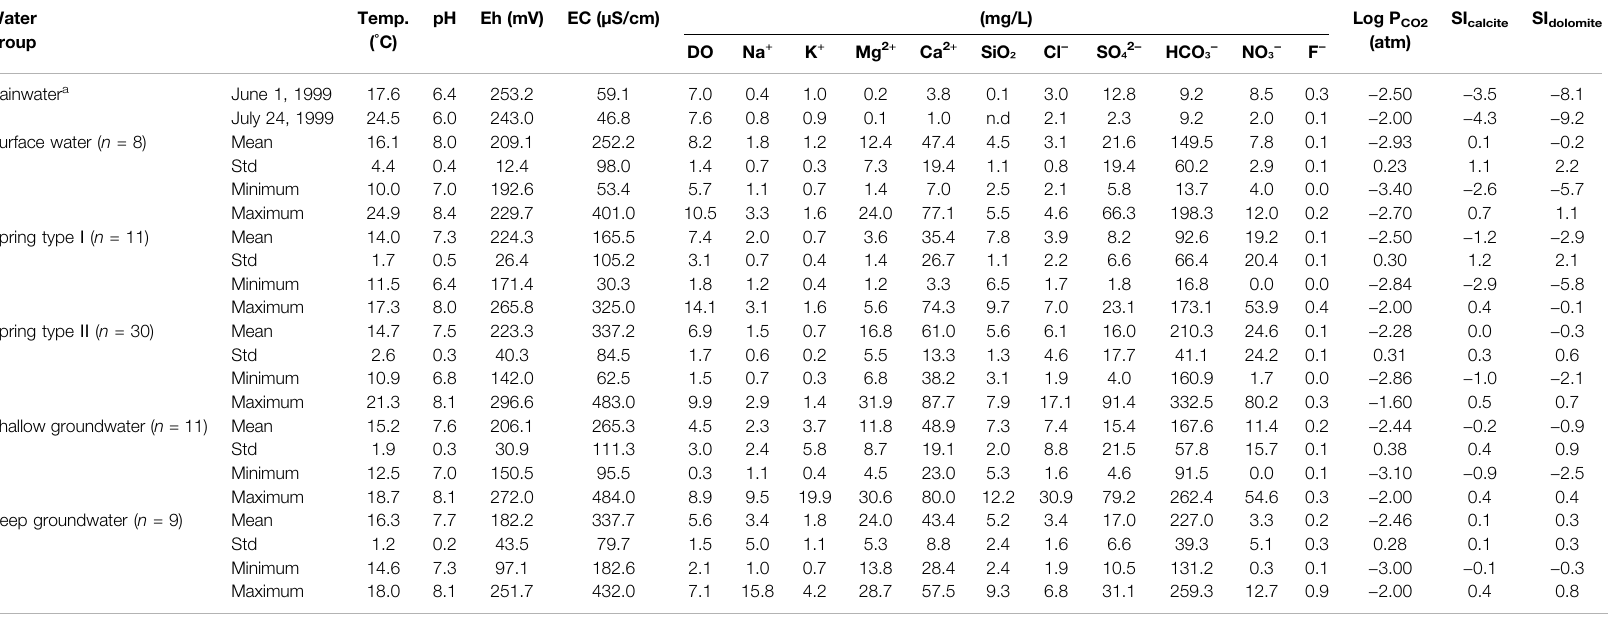
TABLE 1 | Summary of physicochemical data for various kinds of water groups from the Yeongweol area, South Korea. Water group Rainwater a Surface water ( n (cid:1)